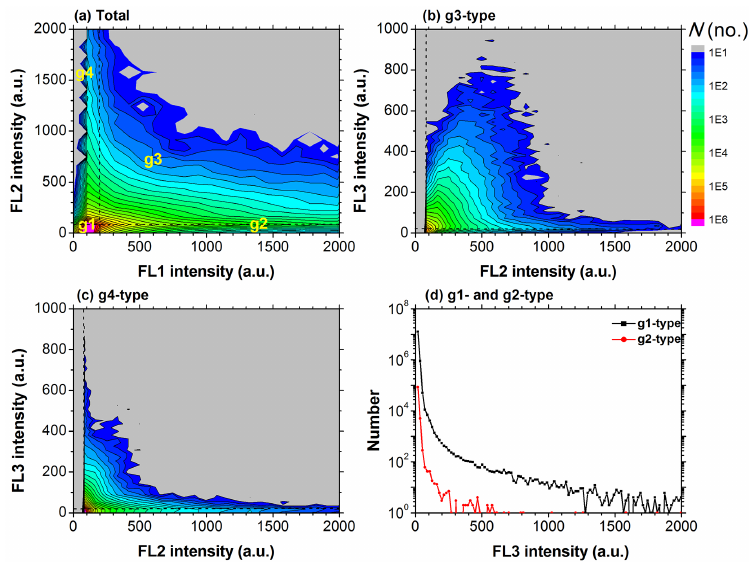
Figure 3. Spectral pattern of the classified fluorescence intensity. FL1 intensity is grouped at 100 intervals, FL2 intensity is grouped at 80 intervals, and FL3 intensity is grouped at 18 intervals. Color scale is the measured particle number. Non-fluorescent and saturating (FL ≥ 2000a.u.) aerosol particles were excluded. (a) FL1 intensity vs. FL2 intensity of total measured particles; (b) FL2 intensity vs. FL3 intensity of g3-type particles; (c) FL2 intensity vs. FL3 intensity of g4-type particles; (d) numbers of g1- and g2-type particles of FL3 fluorescence intensity. Because FL2 intensity of g1 and g2 are below the threshold, the spectral patterns are hence not used. Dotted lines denote the threshold of each channel (200a.u. for FL1, 80a.u. for FL2, and 18a.u. for